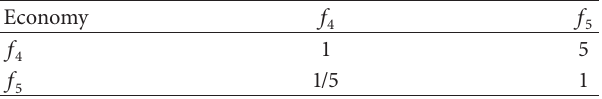
Table 4: Judgment matrix for the economy.